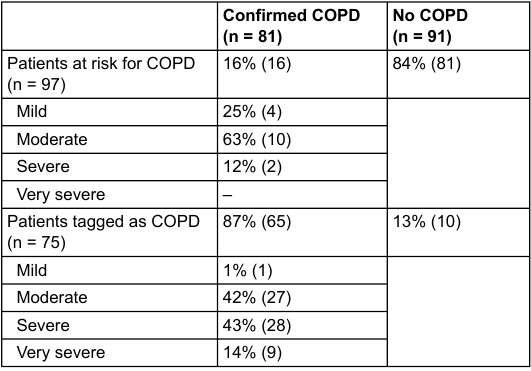
Table 1: Presence of confirmed chronic obstructive pulmonary disease (COPD) and its severity according to inclusion criteria used: patients at risk for COPD vs patients tagged as